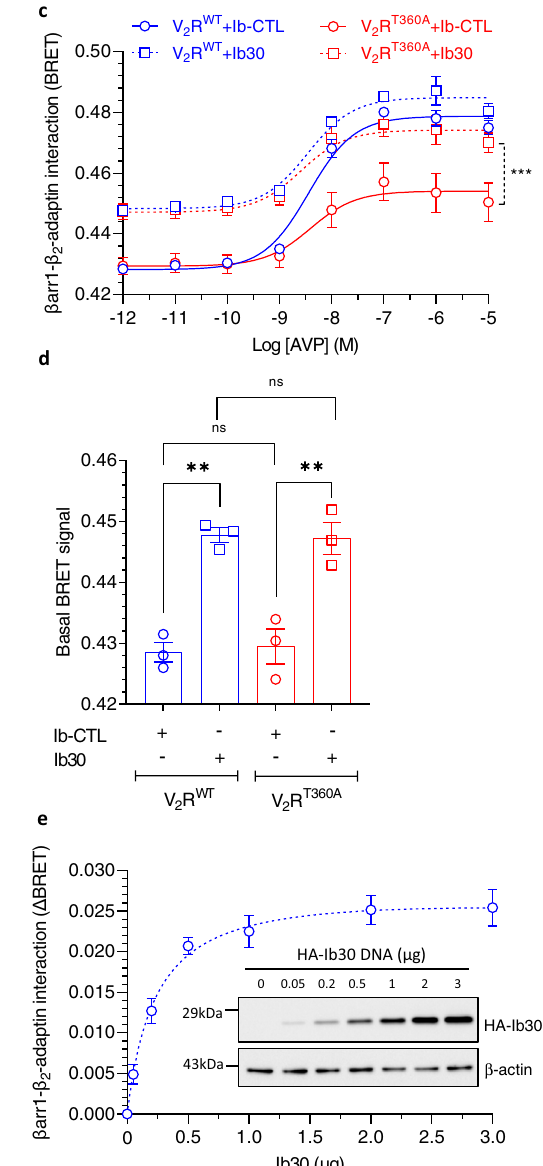
Fig. 9 | Intrabody30 enhances the interaction of β 2 -adaptin with β arr1. a Puri fi ed GST- β 2 -adaptin (592 – 951) was incubated with V 2 R T360A and β arr1 in pre- sence of ScFv-CTL or SvFv30 followed by co-IP and Western blotting. Unconju- gated GST was used as a negative control. A representative blot from